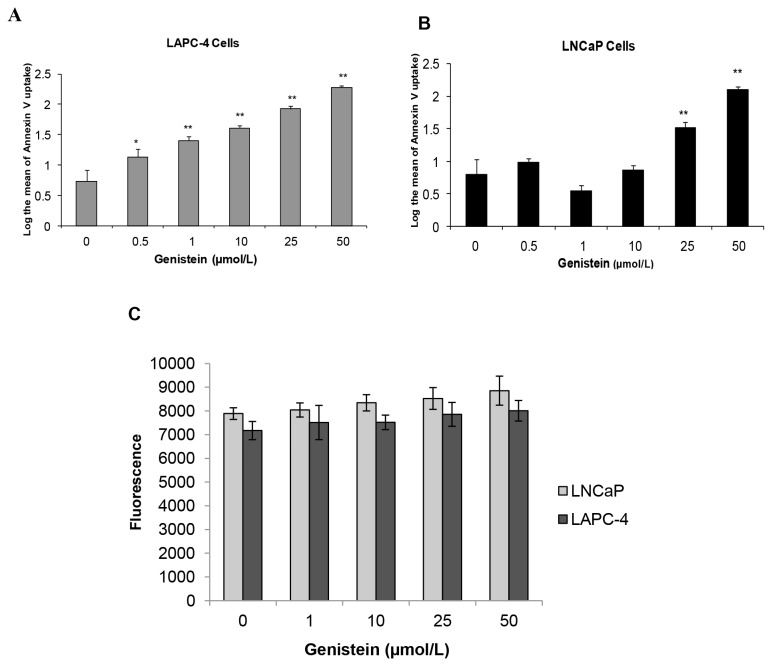
Effects of genistein on PCa cell apoptosis and cytotoxicity.Cells were treated with genistein (0.5- 50 µmol/L) for 48 h, then apoptosis was examined in LAPC-4 (A) and LNCaP cells (B) by flow cytometry after staining with Annexin-V apoptosis detection kit. Cells treated with genistein for 72 hours were tested for signs of cytotoxicity using the lactate dehydrogenase release assay. Results in the graph represent the mean ± SD of three experiments. *p < 0.05, **p <0.01, for comparisons with the control groups.